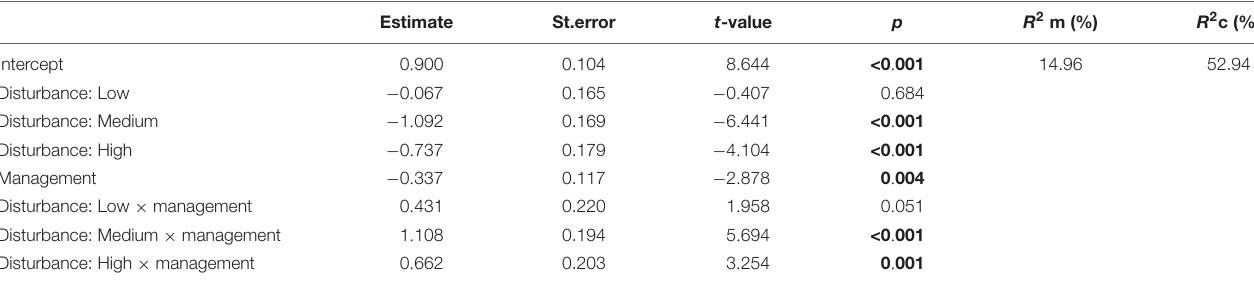
TABLE 2 | Results of GLMM considering productivity (number of fledglings) of Egyptian vultures as the response variable and disturbance types (null, low, medium, and high), management (0 = before management, 1 = after management) as predictive variables (fixed factors) and the interaction between the